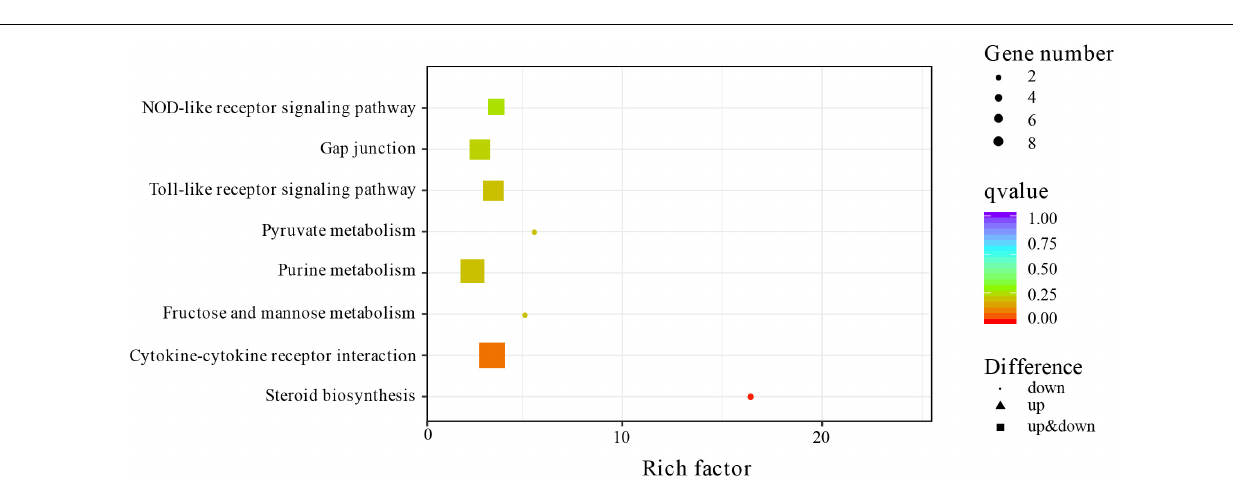
FIGURE 3 | Scatter plot of the Kyoto Encyclopedia of Genes and Genomes (KEGG) pathways of the differentially expressed genes